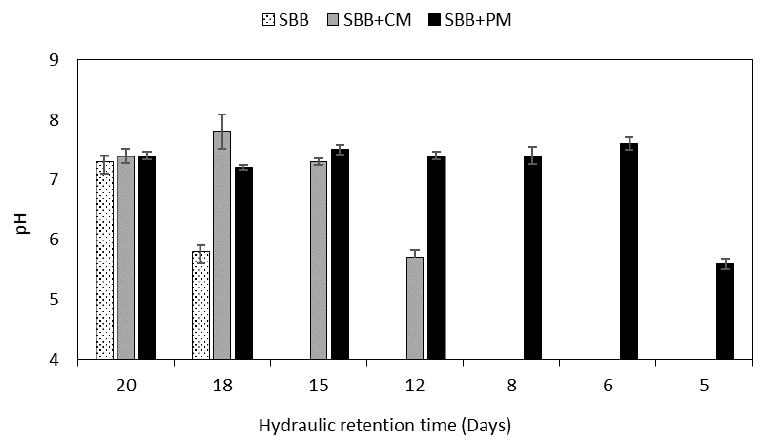
Figure 4. Average pH values in each stage in the three semi-continuous reactors.